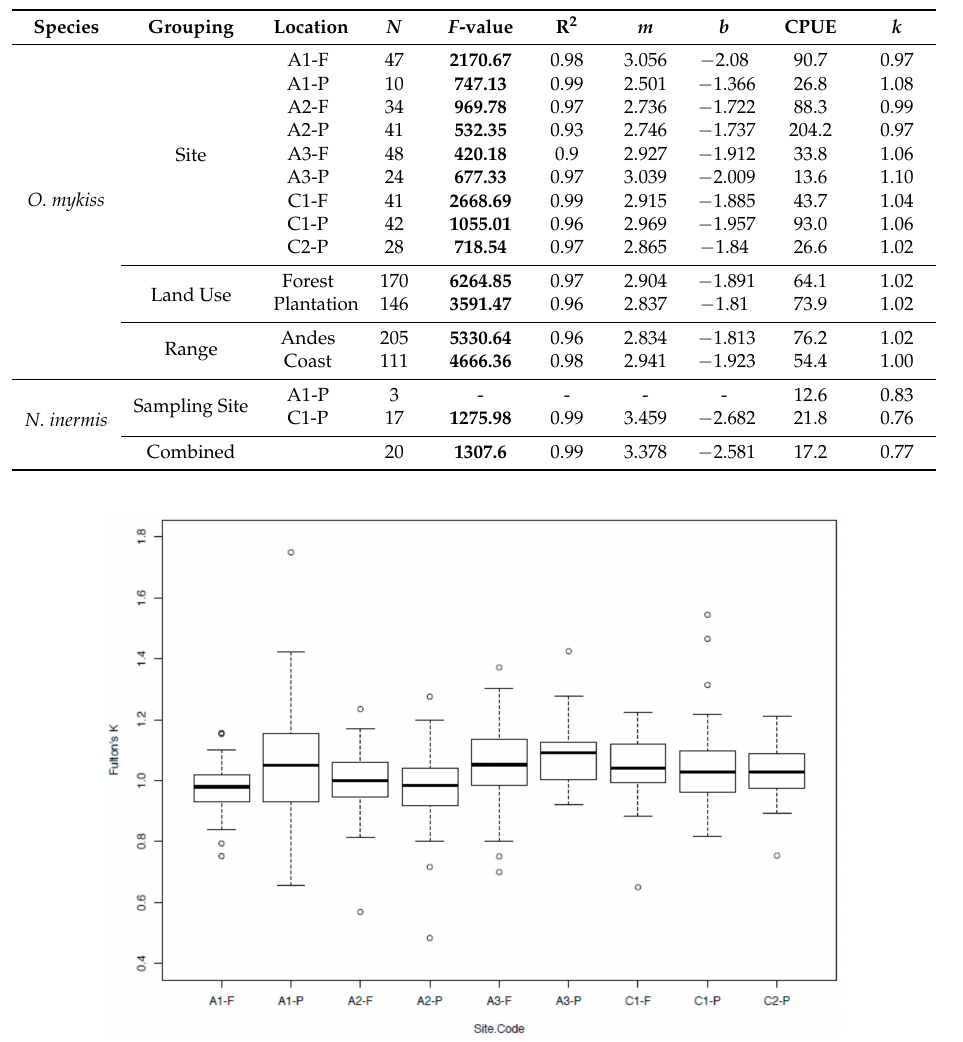
Figure 1. Box plots of Fulton’s k for Oncorhynchus mykiss sampled across nine headwater sites from Central